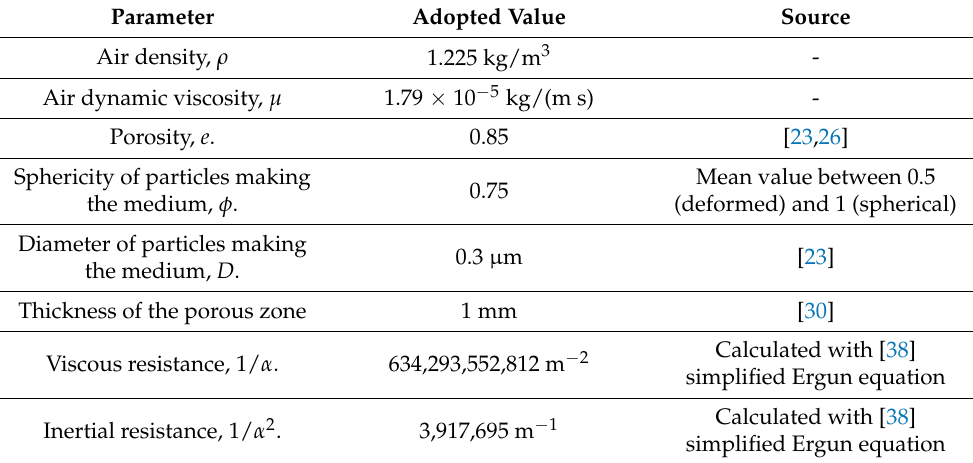
Table 3. Parameters and values adopted in the modeling of the porous medium considering the Ergun equations and Darcy’s law.